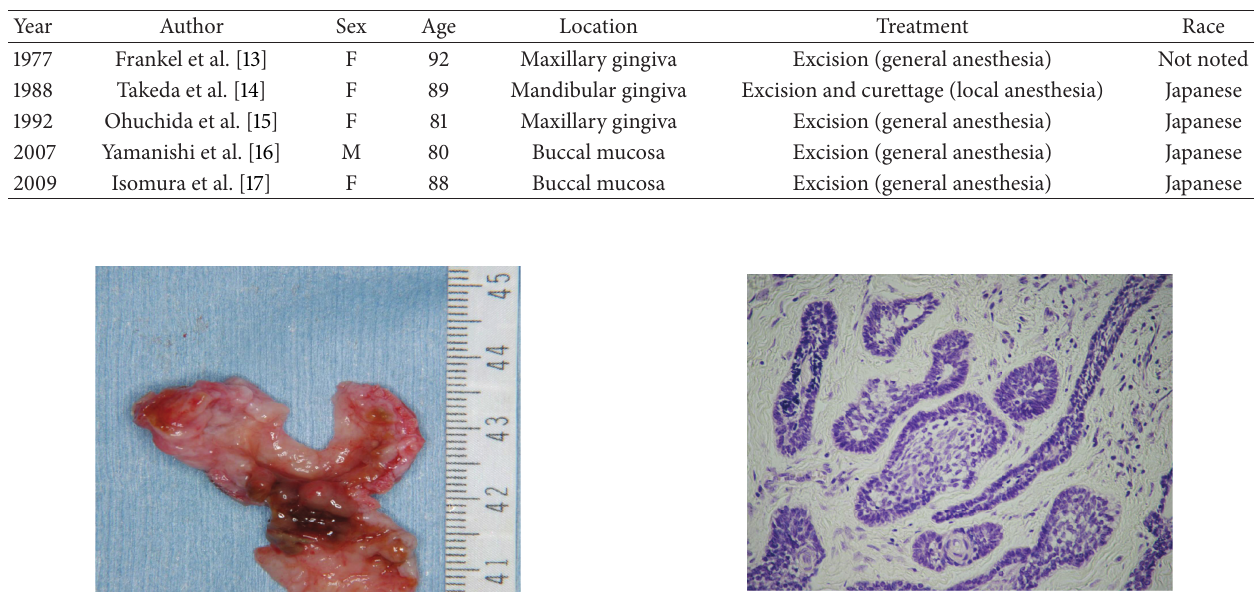
Table 2: Peripheral ameloblastoma.